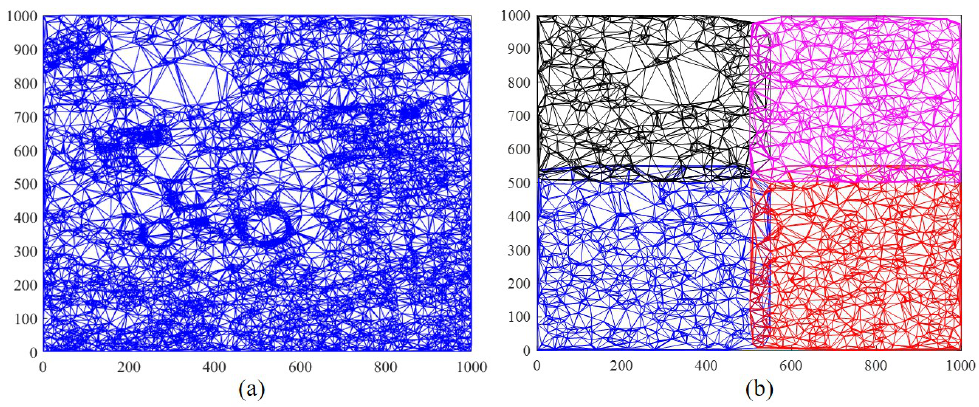
Figure 13. The DTN of the ( a ) NC-PGA and ( b ) BBN-PGA methods in the real data